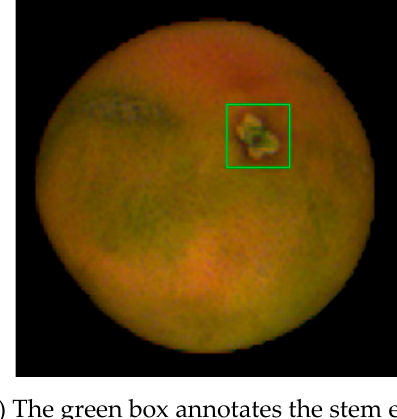
Figure 4. The annotated detection objects. Table 1. Basic information on the pomelo dataset.